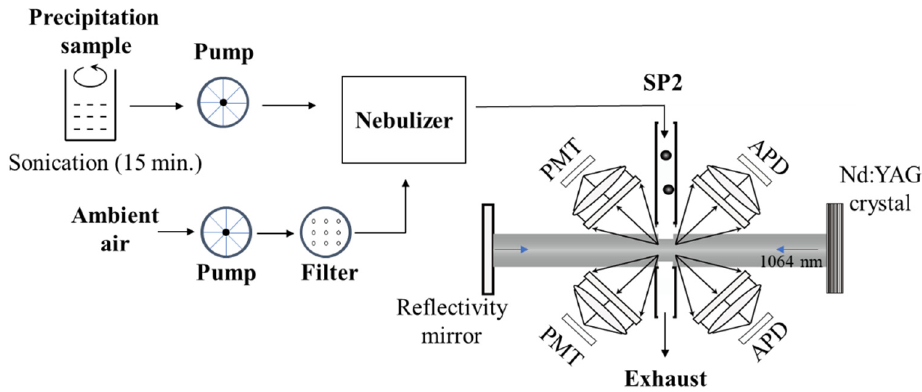
Figure 1. Single particle soot photometer analysis system for testing snow samples.